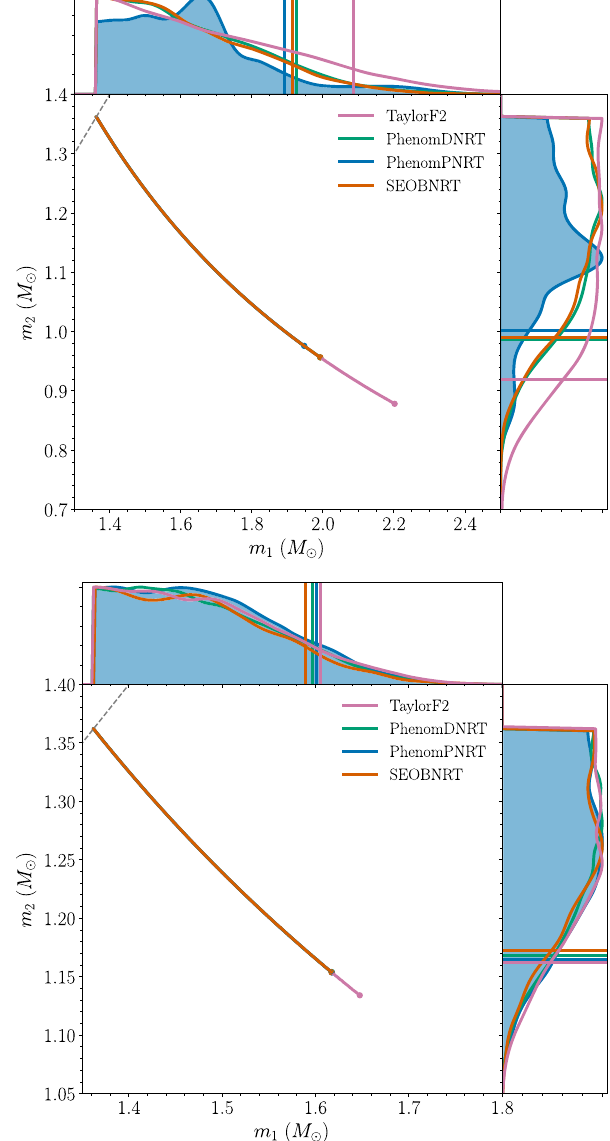
FIG. 5. The 90% credible regions for component masses using the four waveform models for the high-spin prior (top panel) and low-spin prior (bottom panel). The true thickness of the contour, determined by the uncertainty in the chirp mass, is too small to show. The points mark the edge of the 90% credible regions. The 1D marginal distributions have been renormalized to have equal maxima, and the vertical and horizontal lines give the 90% upper and lower limits on m 1 and m 2 ,